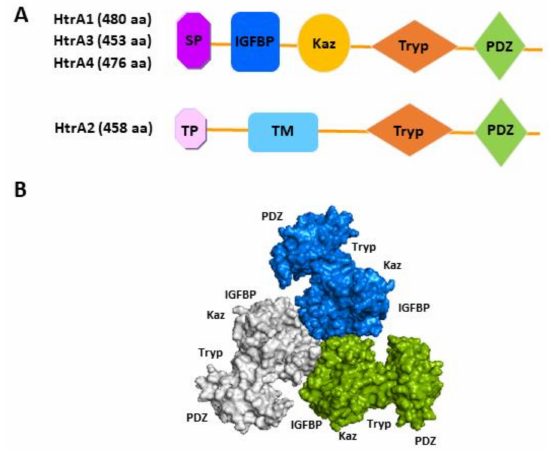
Figure 1. Schematic illustration of protein domain organisation of the four human HtrAs. ( A ) The distinctive N-terminal region of HtrA2 compared to the other three HtrAs; ( B ) The predicted trimeric form of HtrA3 (Adapted from Singh, et al., 2014) [25]. SP, signal peptide; IGFBP, insulin growth factor binding protein domain; Kaz, Kazal-type S protease inhibitor domain; Tryp, trypsin-like serine protease domain; PDZ, postsynaptic density protein 95, Drosophila disc large tumour suppressor and zonula occludens-1 domain; TP, transient peptide; TM, transmembrane domain; aa, amino